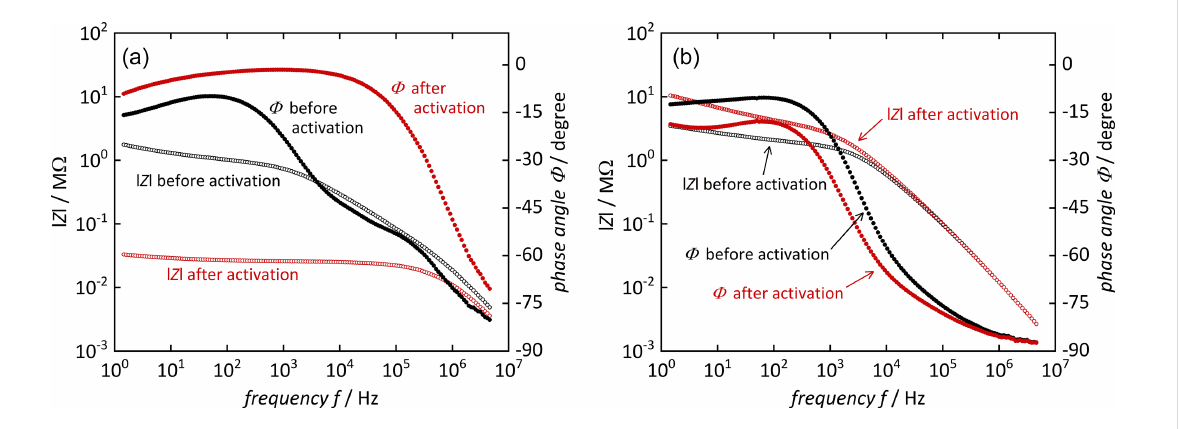
Figure 4: Bode plots (absolute value of impedance Z and phase angle Φ vs frequency f ) of (a) [Mg(H 2 O) 2 (H 3 L)]·H 2 O and (b) [Pb 2 (HL)]·H 2 O, before and after thermal activation. Measurements were conducted at 22 °C and 90% r.h.